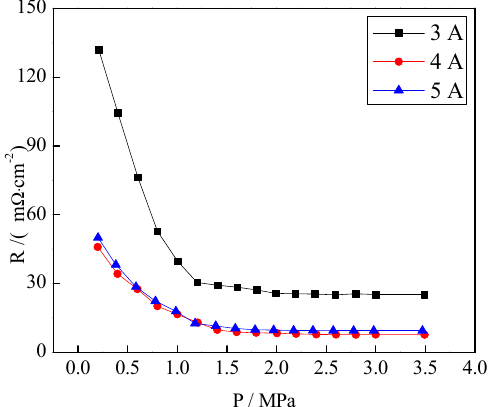
ff erent filament